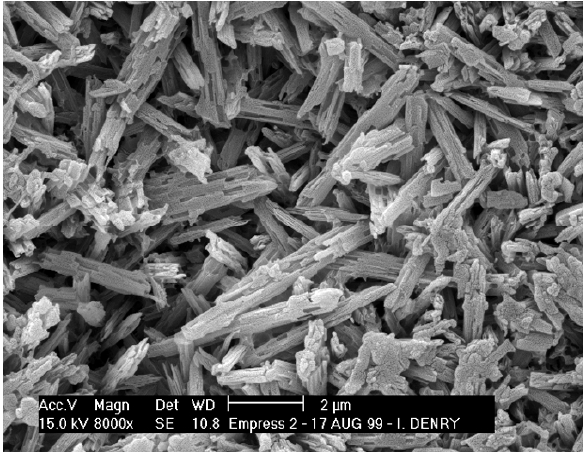
Figure 4. Microstructure heat-pressed lithium disilicate glass-ceramic.